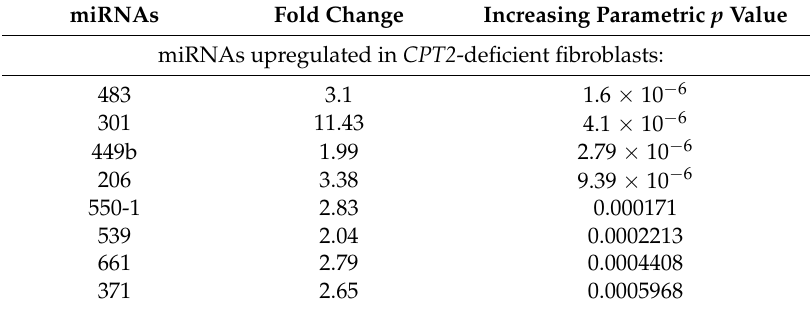
Table 1. MiRNAs whose expression changed in human CPT2 -deficient primary fibroblasts as compared with control primary human fibroblasts, as deduced from microRNA microarray analysis. Geometric mean of intensities <100 were considered as background and discarded. Changes were considered significant for p <